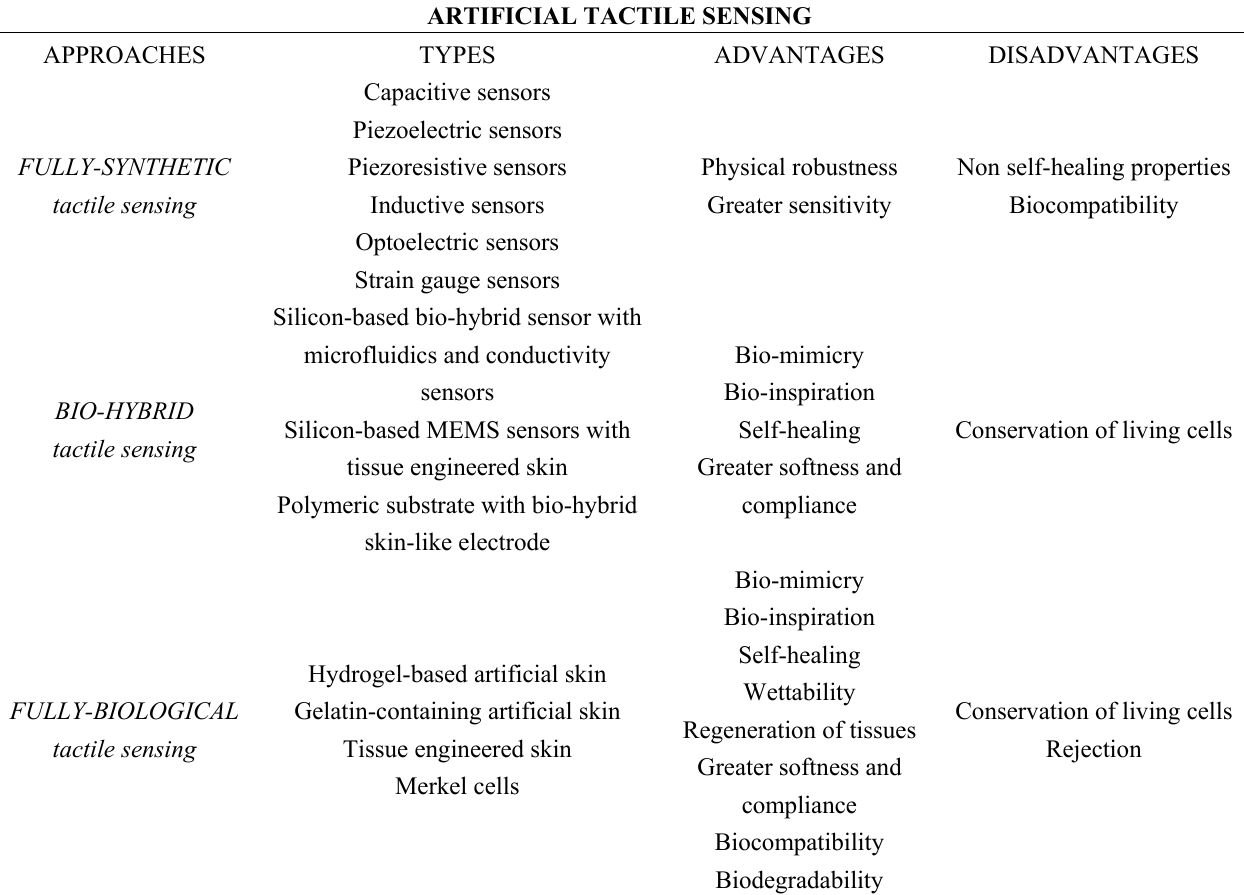
(Table 5): synthetic approaches (e.g., piezoelectric, piezoresistive, strain gauge, capacitive, inductive and optoelectric sensors) versus bio-artificial ones (here classified as bio-hybrid and fully-biological). Table 5. Comparison between approaches for artificial tactile sensing: fully-synthetic, bio-hybrid and fully-biological tactile sensing. Advantages and disadvantages of each